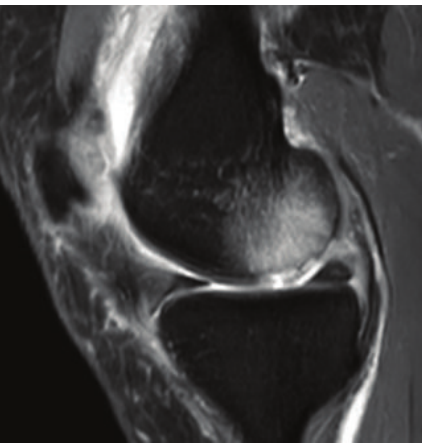
Figure 1: Sagittal T2-weighted MRI of left knee joint depicting cartilage lesion and large underlying BME at dorsomedial femoral condyle.